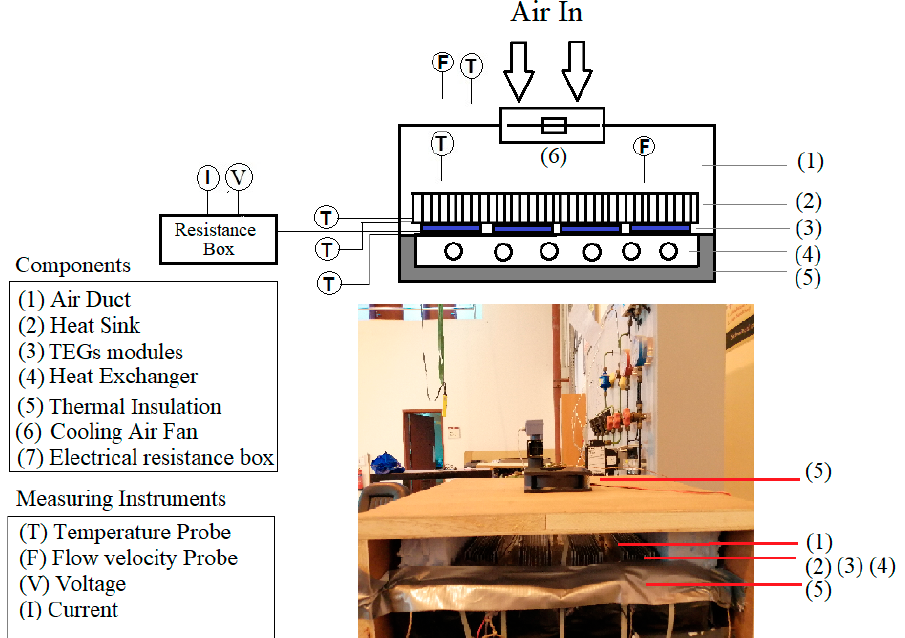
Figure 3. Assembly of HE-TEGs unit and measuring instruments.